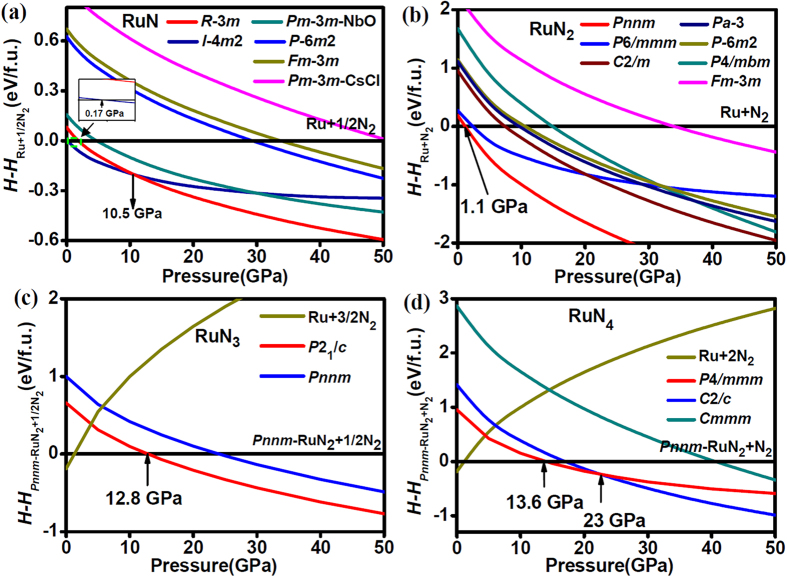
(a,b) Formation enthalpies of RuN and RuN2 with respect to Ru and nitrogen as a function of pressure, respectively. (c,d) Relative formation enthalpies of RuN3 and RuN4 with respect to Pnnm-RuN2 and nitrogen as a function of pressure, respectively.